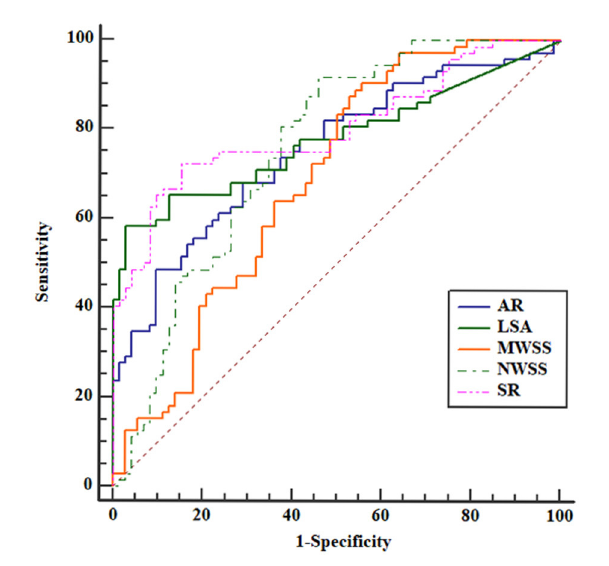
FIGURE 3 | Receiver operating characteristic (ROC) curves for all the independent risk factors. The area under the curve (AUC) areas of size ratio (SR), aspect ratio (AR), LSA, mean WSS, and normalized wall shear stress (NWSS) were 0.803, 0.751, 0.778, 0.686, and 0.755, respectively. The SR had the largest AUC